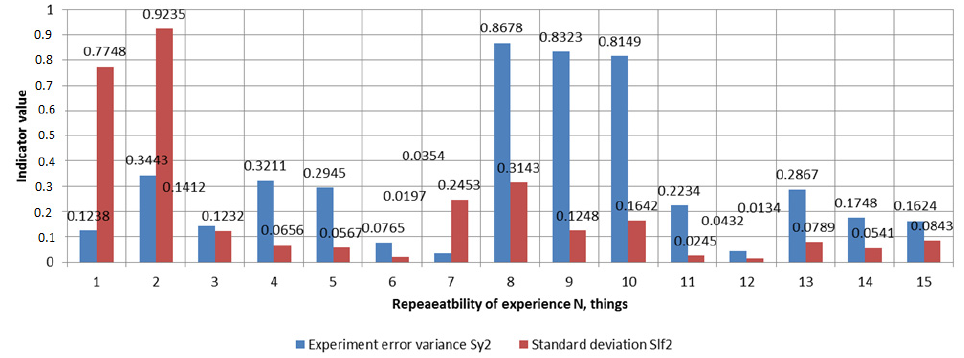
Figure 12. Plot of observed values (empirical cumulative distribution) versus expected frequencies (theoretical cumulative distribution).